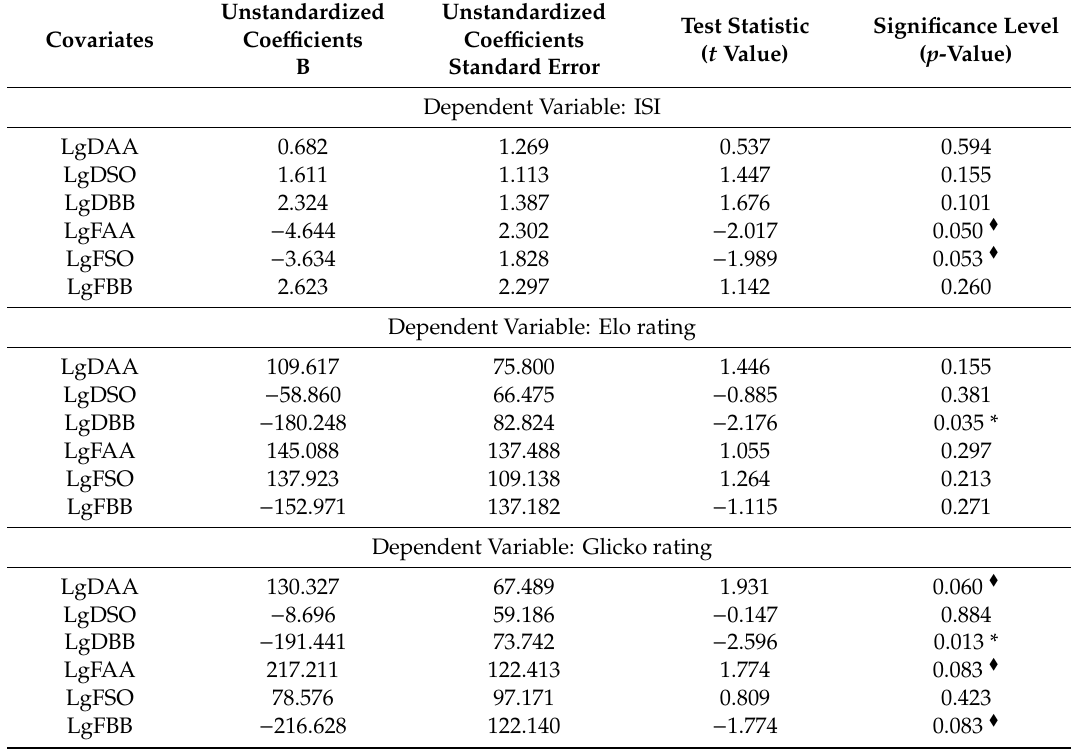
Table 2. Regression coe ffi cients and standard errors for multiple linear regression analyses of logarithms of dyadic behavior indicators for hierarchical indices ISI, Elo rating, and Glicko rating.